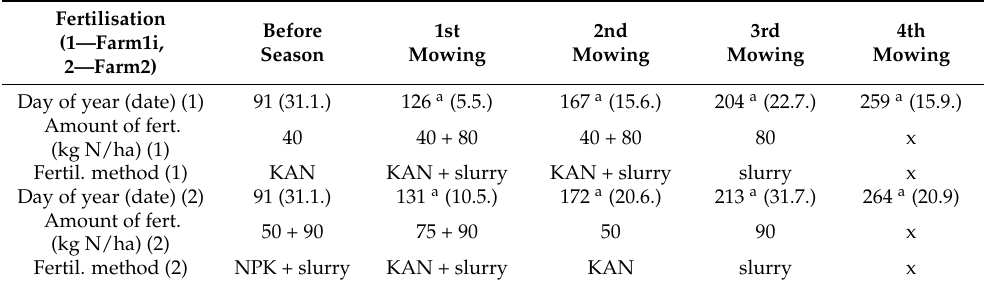
Table 1. Review of days of fertilisation, amounts of fertilisers, and fertilisation methods based on